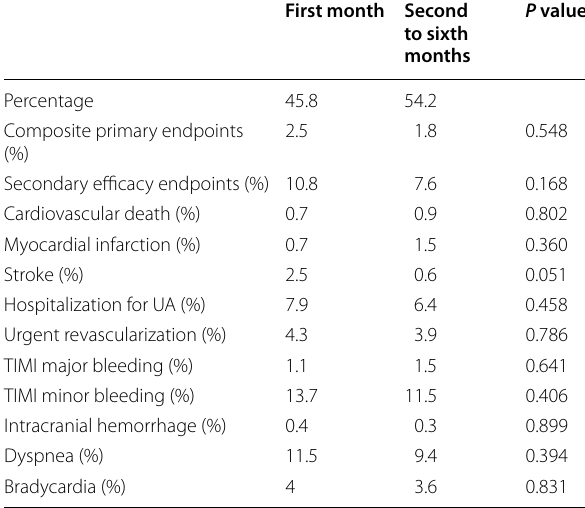
Table 3 Efficacy and safety outcomes in patients who were enrolled in the first month after ACS compared to those who were enrolled from the second to the sixth months after